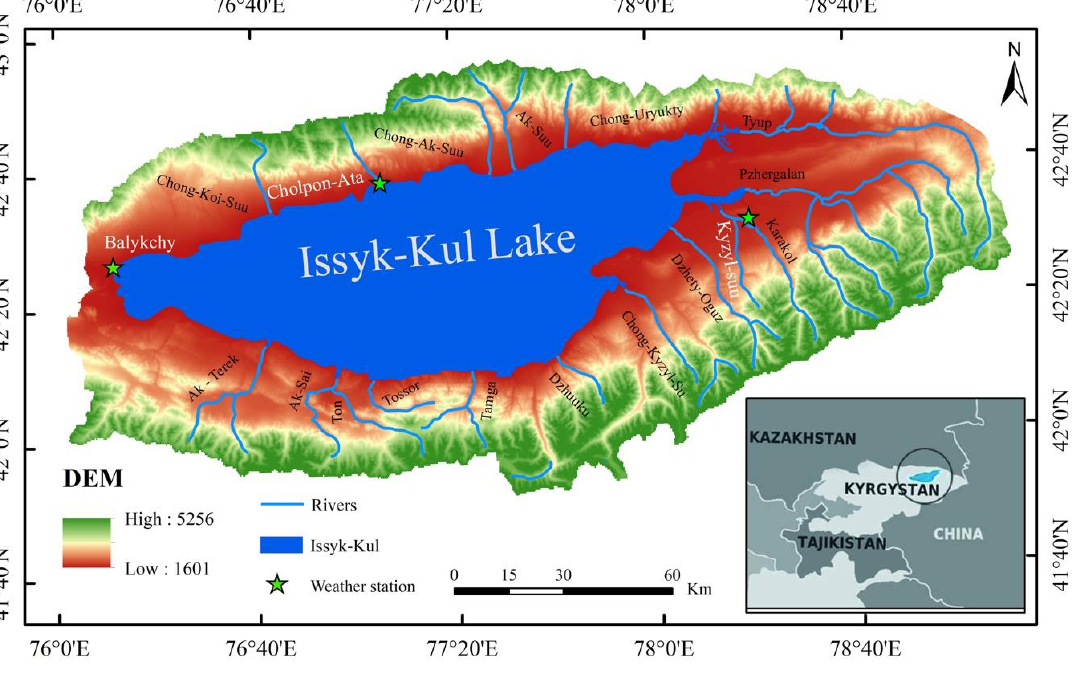
Figure 1. The location of Lake Issyk-Kul Basin, Kyrgyzstan, Central Asia.